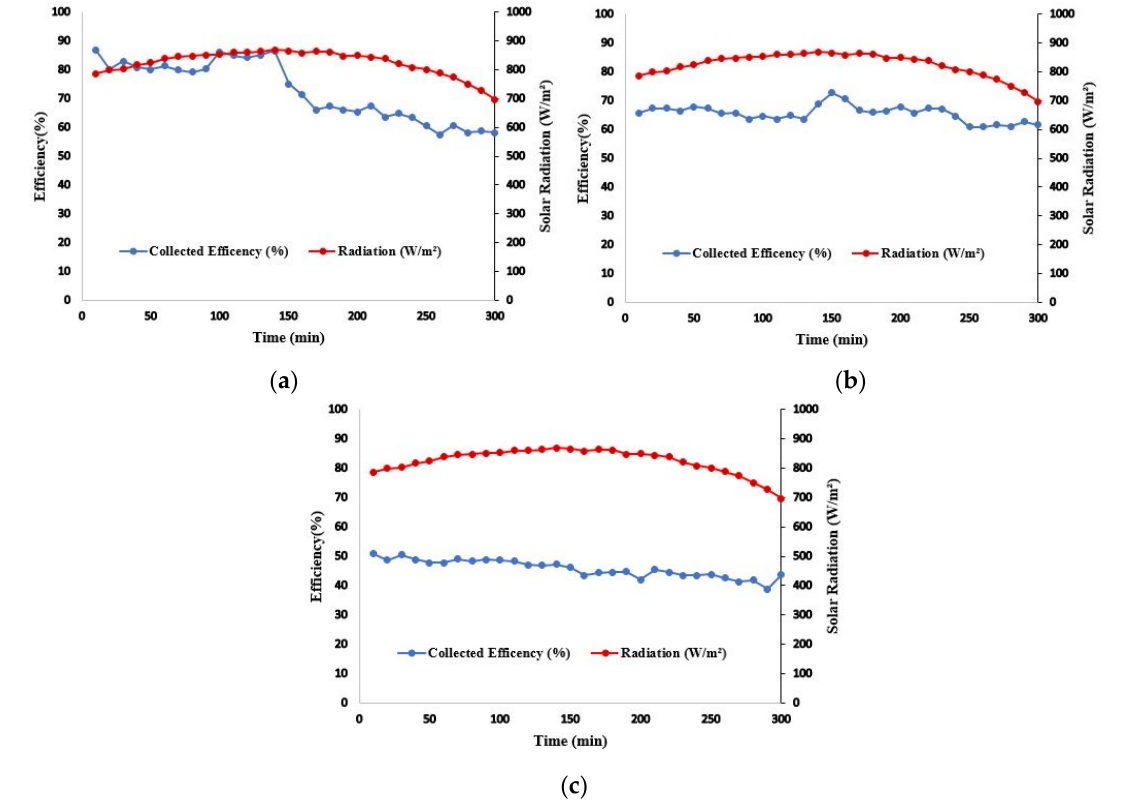
Figure 4. Collected efficiency using ( a ) Al 2 O 3 , ( b ) CuO, and ( c ) distilled water at 6 L/min. The heat collection efficiency decreased with time, and it was judged that convective heat loss increased as the inlet temperature increased. The heat collection efficiency using the Al 2 O 3 nanofluid was the highest. It was observed that the Al 2 O 3 nanofluid absorbs a greater amount of heat than water and CuO under similar ambient conditions; therefore,